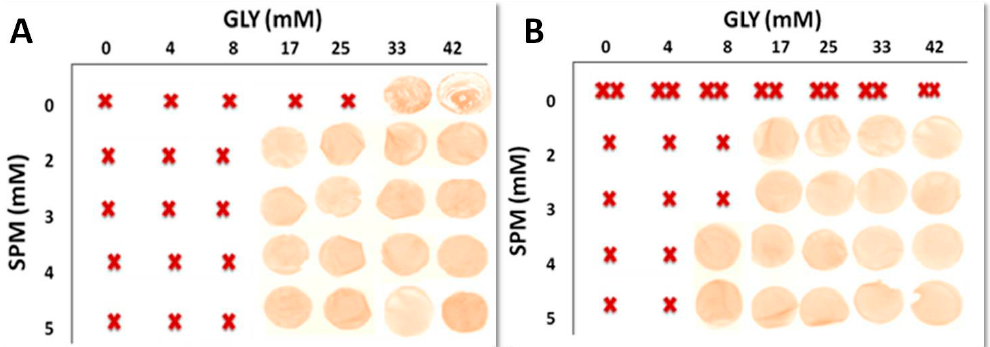
Figure 4. Films obtained by casting BVPC FFSs previously incubated for 30 min, either at 25 °C ( A ) or 80 °C ( B ), at pH 8.0 and in the presence of different concentrations of SPM and/or GLY. Not handleable –either brittle (X) or sticky (XX)- and handleable (photo) films are indicated. Further experimental details are given in the text.